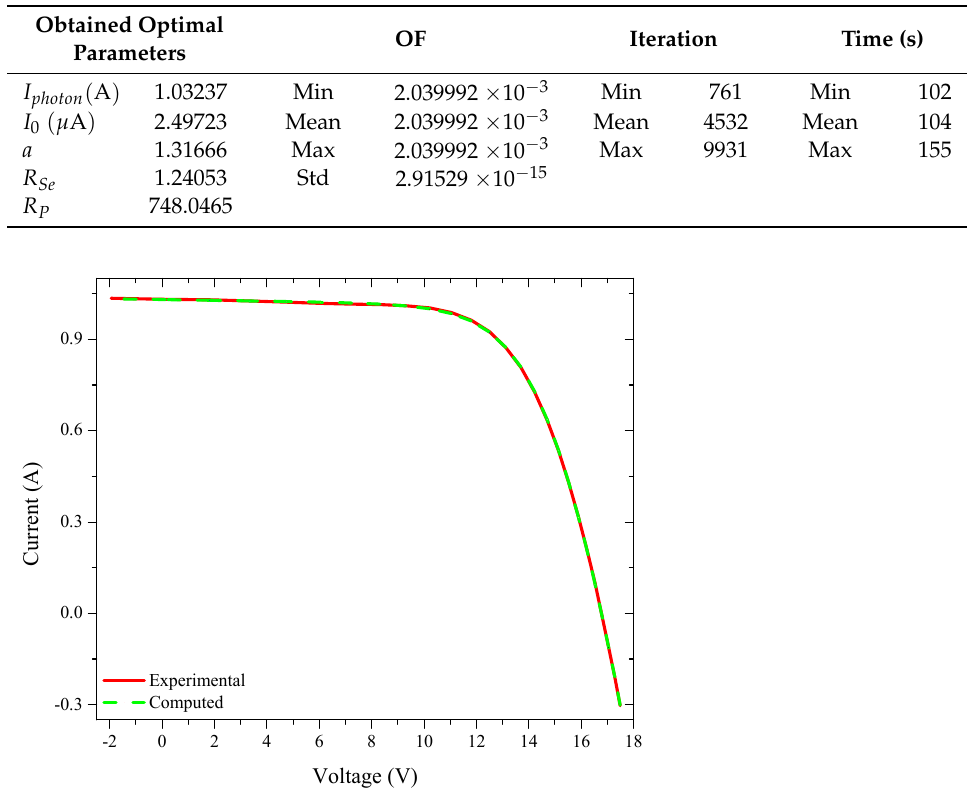
Figure 9. I–V curve of the SDM PV module for experimental and computed current values.